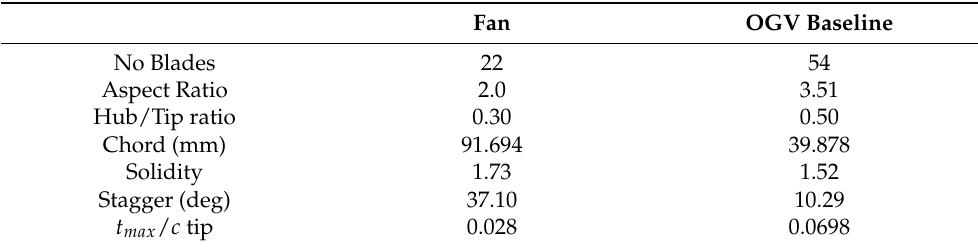
Table 1. NASA/GEAE R4 characteristics.